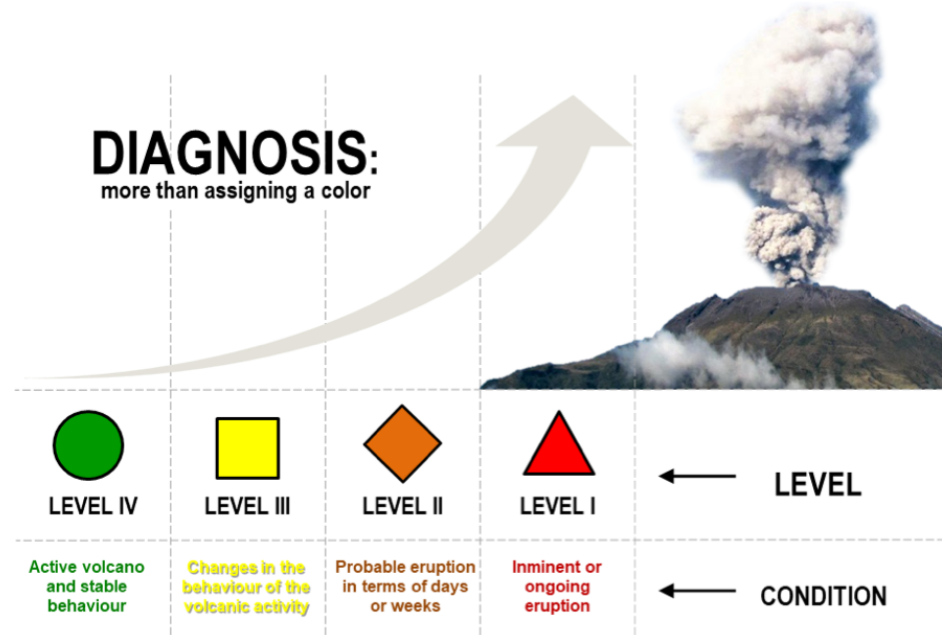
Figure 3: The volcanic activity levels established by the SGC for Colombian active volcanoes that have instrumental monitoring